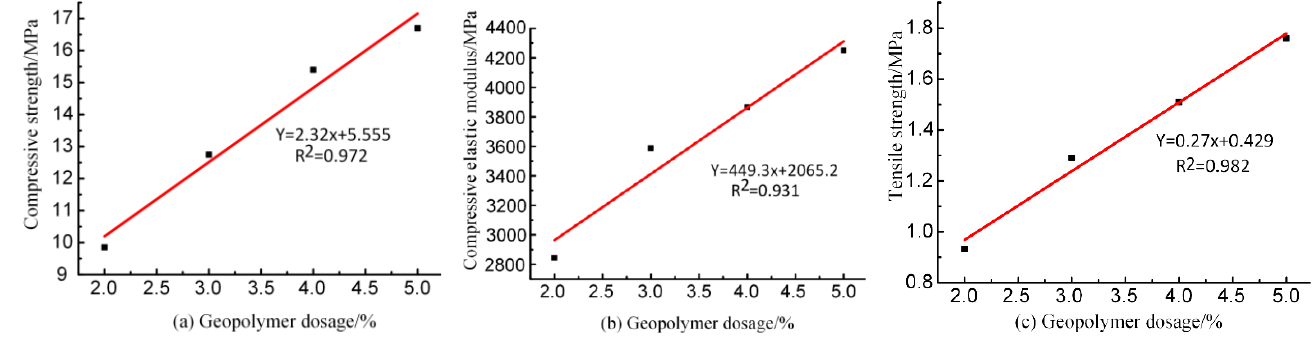
Figure 2. Effect of different geopolymer dosage on mechanical properties of specimens. ( a ) Compressive strength. ( b ) Compressive elastic modulus. ( c ) Tensile strength.